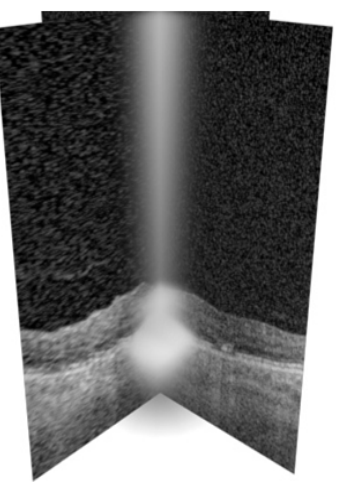
Figure 5. Three-dimensional model of laser exposure.